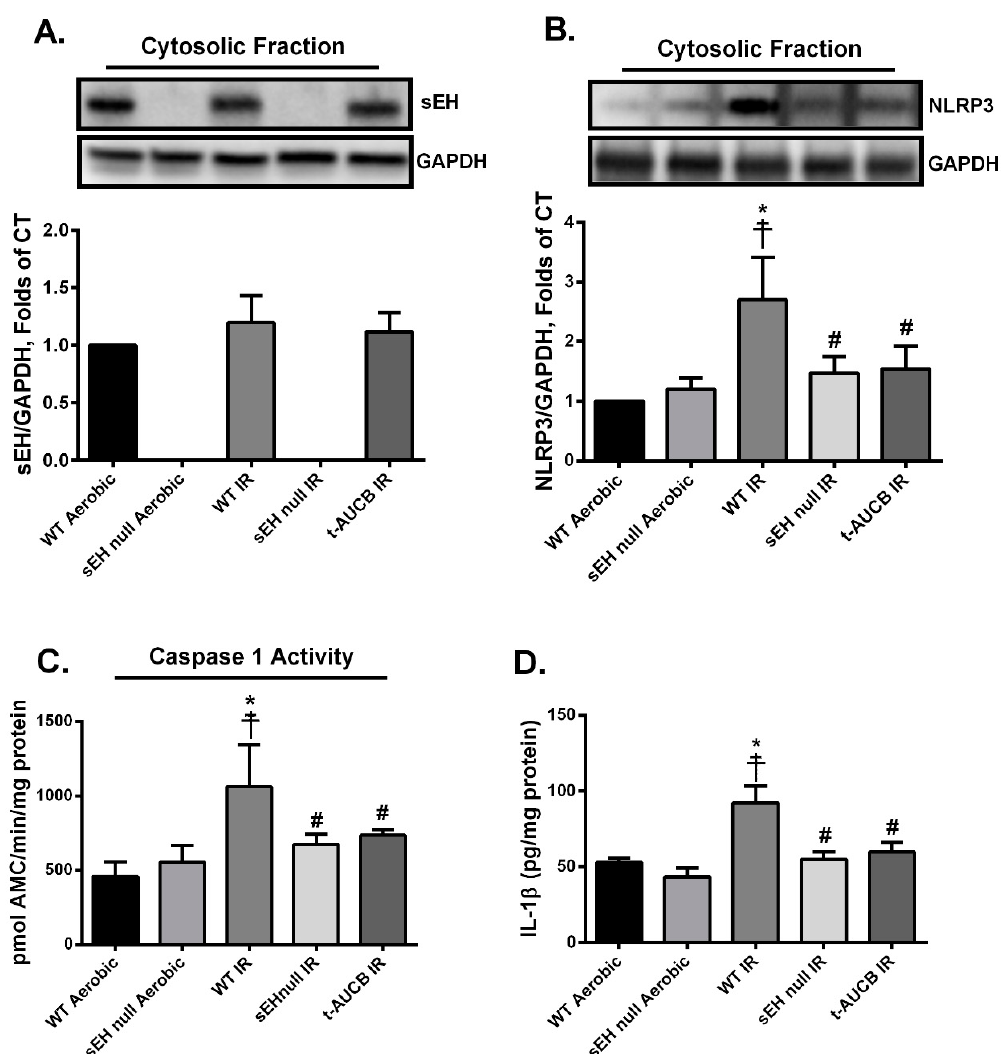
Figure 4. Genetic deletion of Ephx2 or pharmacological inhibition of sEH inhibited IR-induced nucleotide-binding oligomerization domain-like receptor (NLR) family pyrin domain containing 3 (NLRP3) inflammasome formation and activation. Representative immunoblots and densiometric Table 1. Mitochondrial respiration was measured in permeabilized cardiac fibers freshly isolated at the end of reperfusion.